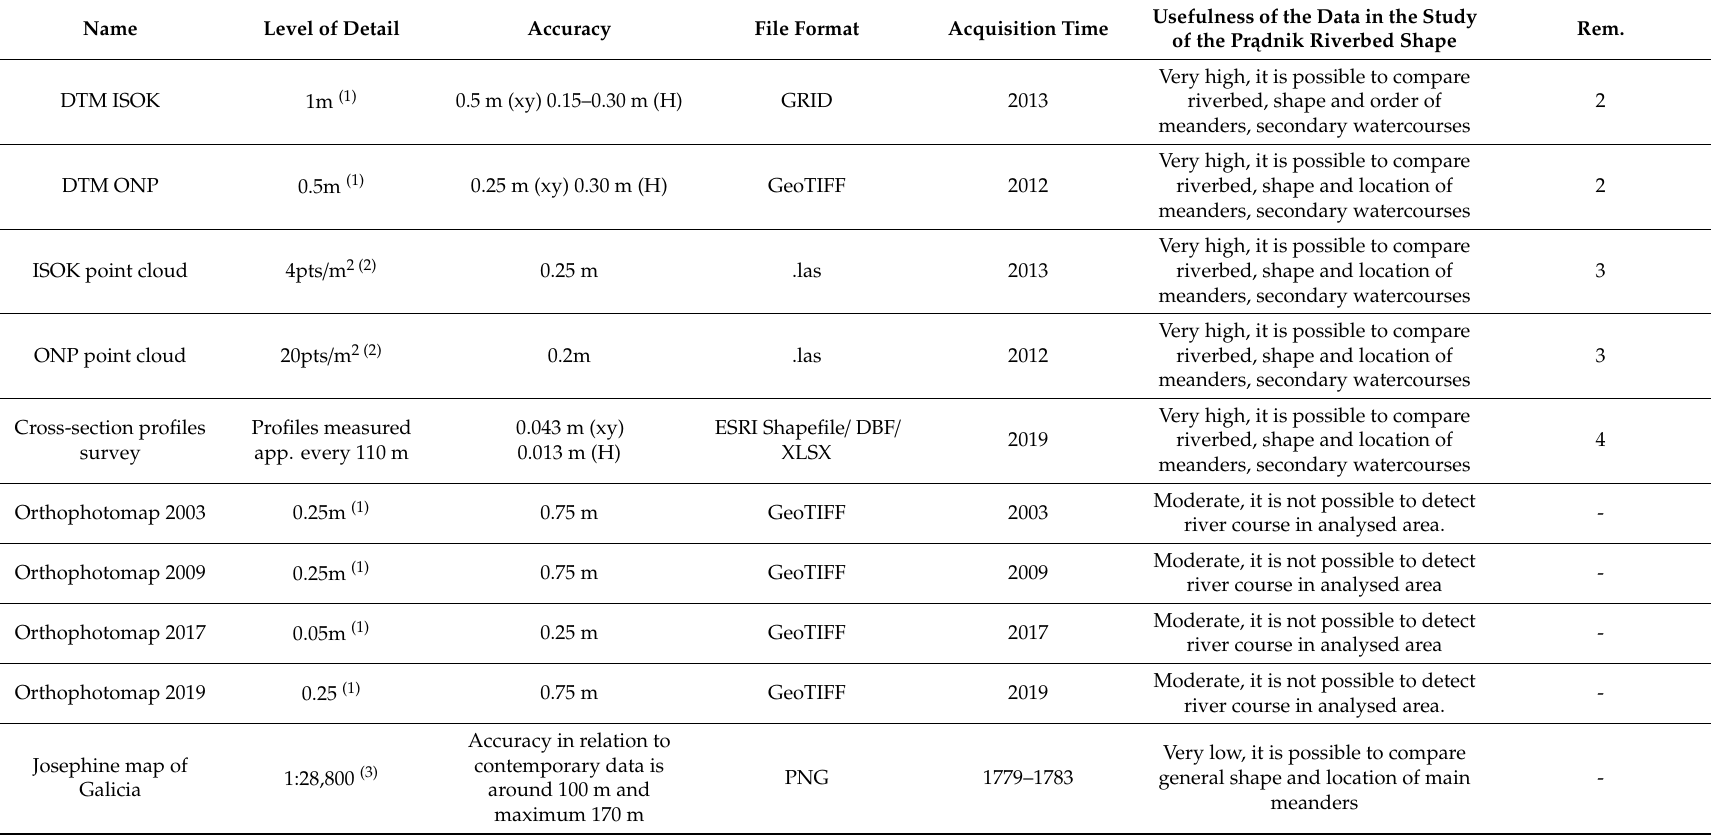
Table 8. Summary of the analysed data sets and their